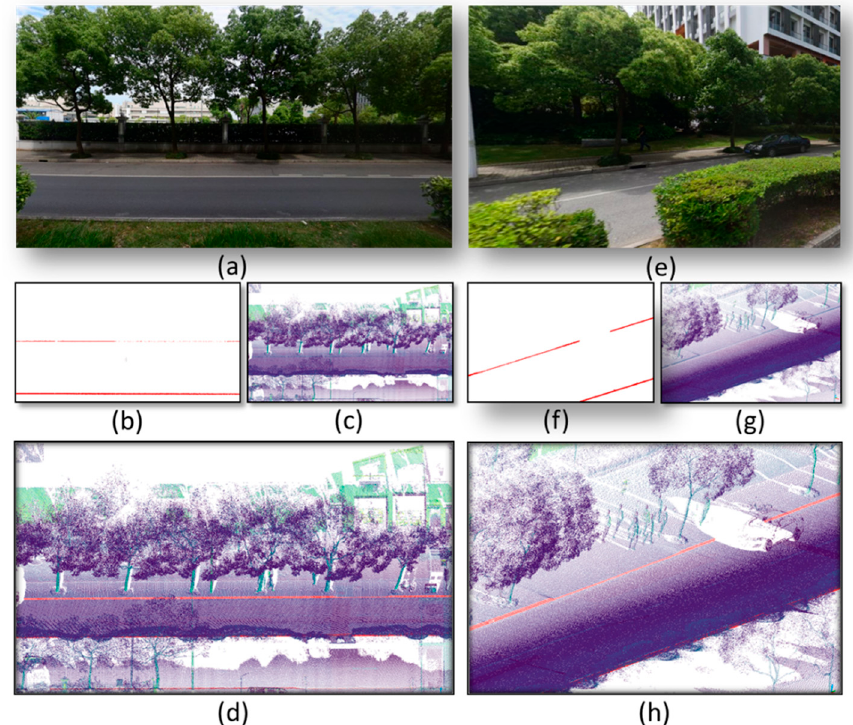
Figure 16. Extraction results of occlusion curbs. ( a , e ) Two detail views of study sites; ( b , f ) The result of curb extraction by proposed method; ( c , g ) Original point cloud; ( d , h ) Point cloud of the studied area overlapped by segmented curbs.